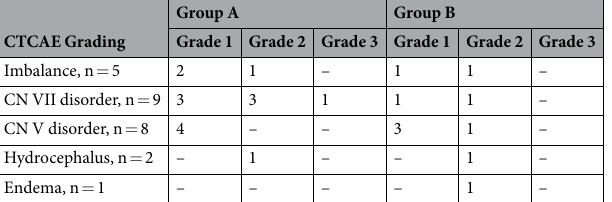
Table 3. Overview of permanent side-effects after SRS using CTCAE criteria. A total of 20 patients (7.5%) reported permanent complaints after SRS. In some cases multiple symptoms occurred. In our series CTCAE criteria were grade 1 (mild symptoms, asymptomatic or mild symptoms without impact on daily life), grade 2 (moderate, minimal, local or noninvasive intervention indicated; limiting age-appropriate instrumental activities of daily life (ADL)), and grade 3 (severe or medically significant, but not immediately life-threatening; hospitalization or prolongation of hospitalization indicated; disabling; limiting self care ADL). We did not find any adverse events matching grade 4 (life-threatening consequences; urgent intervention indicated) or grade 5 (death related to AE).